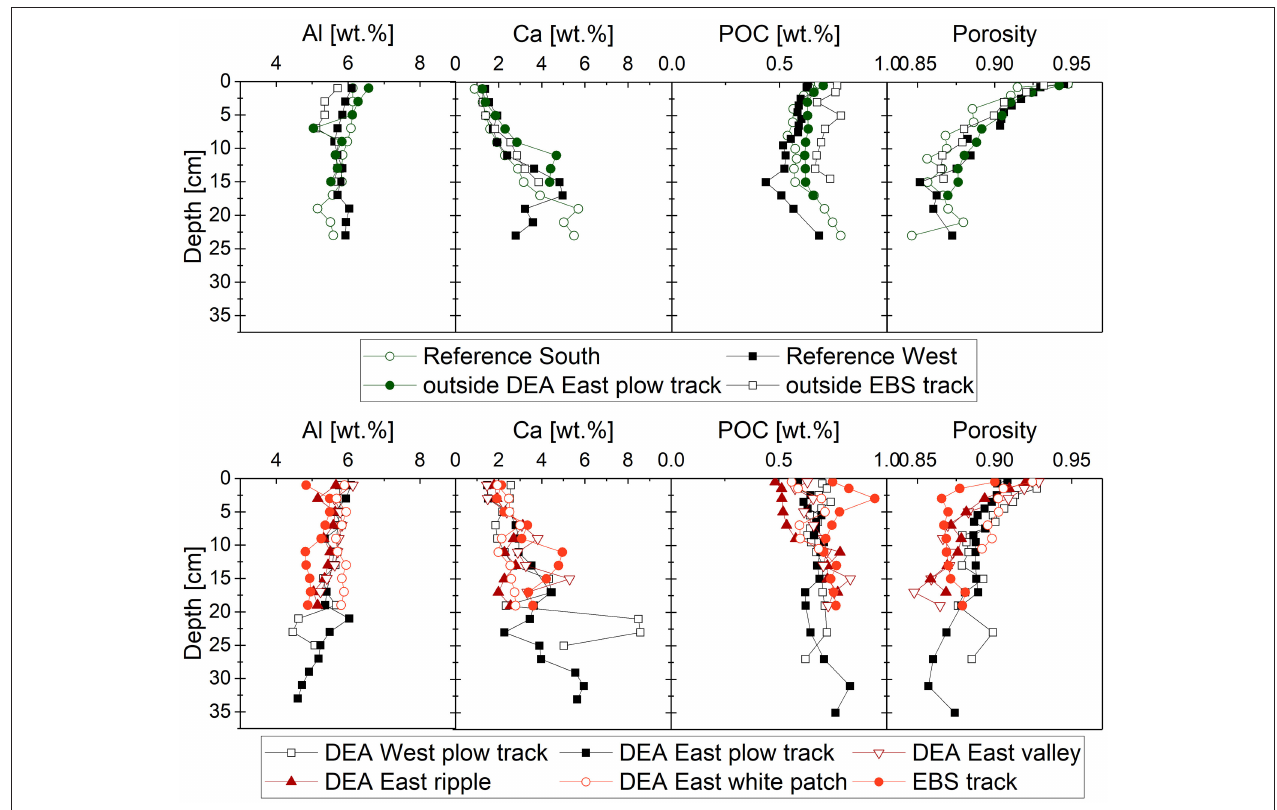
FIGURE 3 | Sediment major element profiles and properties of the four undisturbed and six disturbed sites.